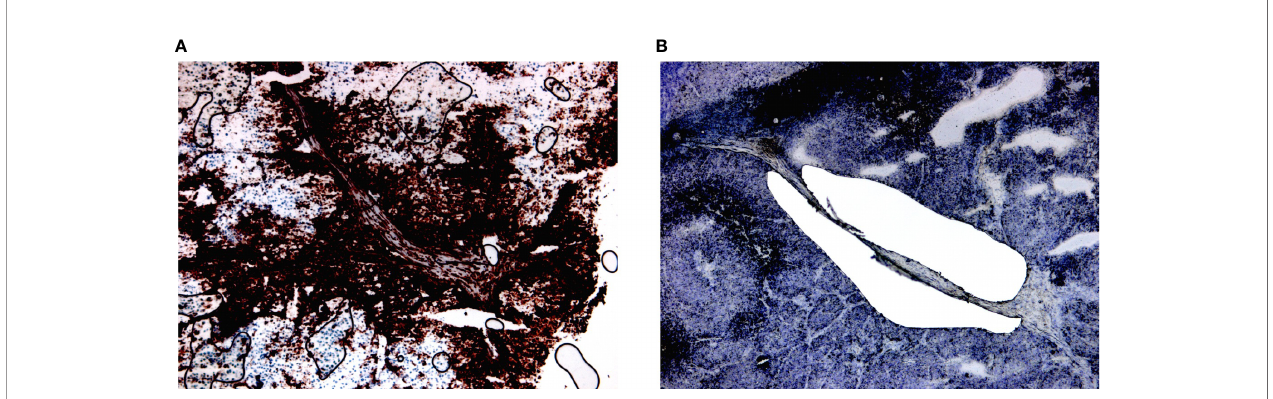
FIGURE 2 | Laser microdissection of HLA-DR+ areas in HLA-DR+ tumors. (A) HLA-DR+ areas were identi fi ed using conventional immunohistochemical staining for HLA-DR. HLA-DR expression in melanoma cells located at the margin of the tumors at margins of the tumour nodules, at the so-called tumour-stromal interface. (B) Laser microdissection was executed on the immediately consecutive section after morphological recognition of the HLA-DR+